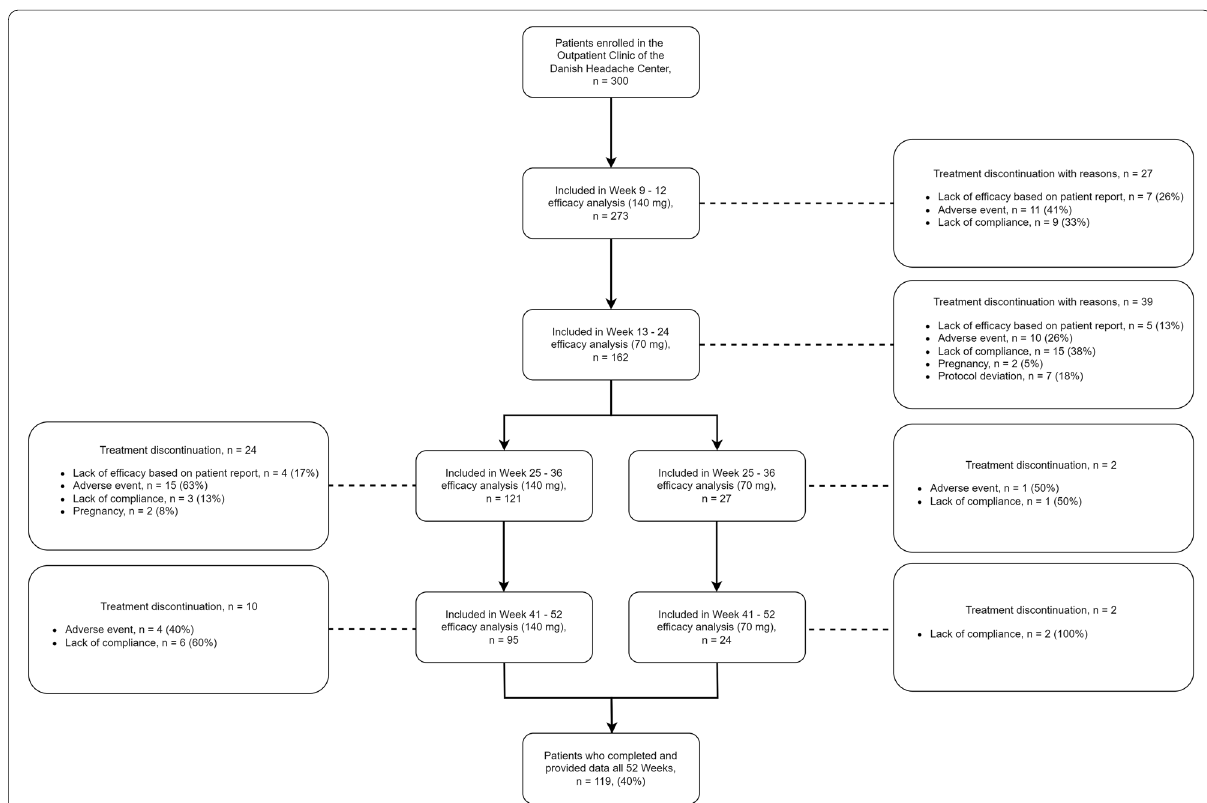
Fig. 1 Patient Flowchart and Disposition. All patients were started on 140‑mg erenumab and received this dose from week 1 through week 12. After the initial 12 weeks of treatment, all patients had a dose reduction and received 70 mg erenumab from week 13 through week 24. From week 24 through week 52, patients continued with the dose with the highest efficacy (140‑mg or 70‑mg). Final evaluation was conducted at week 52